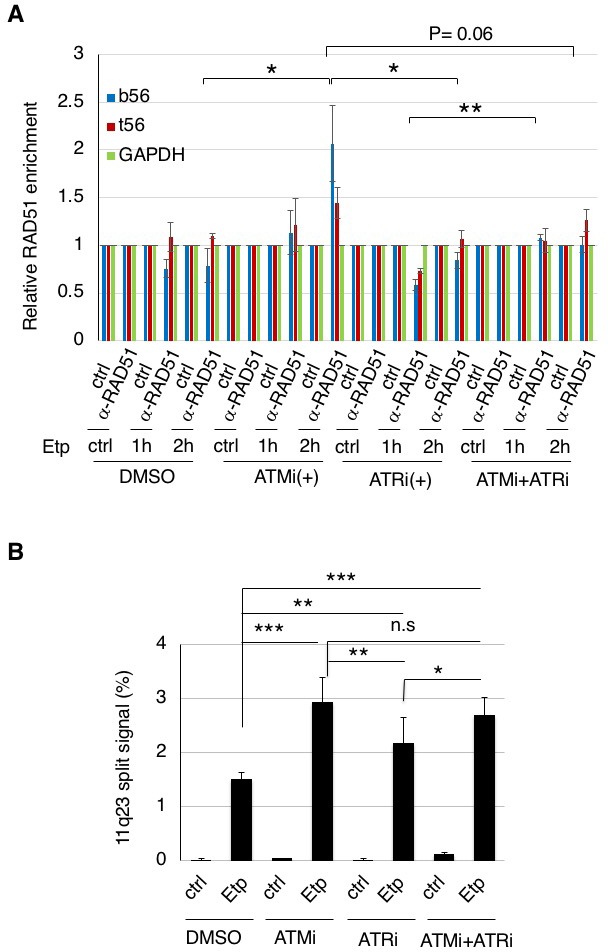
ATM, but not ATR, negatively regulates RAD51 loading onto the BCR after etoposide treatment to repress 11q23 chromosome translocations.(A) ChIP analysis of the RAD51 loading onto the MLL BCR in ATMi or ATRi or a combination of ATMi and ATRi treated 11–4 cells. 11–4 cells were treated with ATMi (10 µM), ATRi (10 µM), or a combination of ATMi and ATRi for 2 hr before etoposide treatment. After washing the cells, the inhibitors (5 μM) were added until the cells were harvested. The ChIP analysis was performed as described in Figure 4. Values represent the means ± SE from three independent experiments. *p<0.05. **p<0.01. Source data are presented in Figure 6—source data 1. (B) The percentages of 11–4 cells with split chromosome 11q23 signals are shown. 11–4 cells were treated with ATMi (10 µM), ATRi (10 µM), or a combination of ATMi and ATRi for 2 hr before etoposide treatment. After the cells were washed, the inhibitors (5 μM) were added until the cells were harvested. Dual-color FISH analyses of chromosome 11q23 were performed as described in Figure 5. Values represent the means ± SE from three independent experiments. *p<0.05. **p<0.01, ***p<0.001, n.s.: no significant difference.10.7554/eLife.32222.026Figure 6—source data 1.Source raw data for Figure 6A and B.